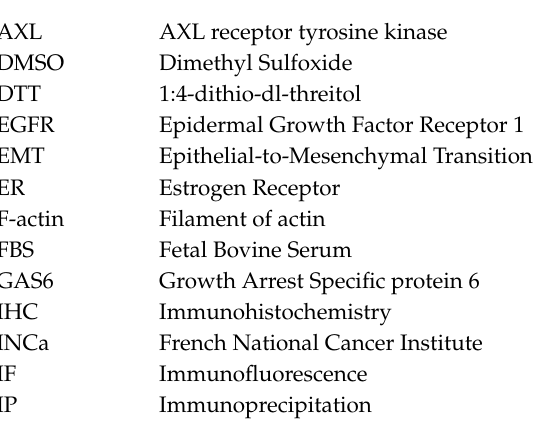
Supplementary Materials: The Table S1 and Figures S1–S4 are available online at http: // www.mdpi.com / 2073- 4409 / 9 / 1 / 247 /